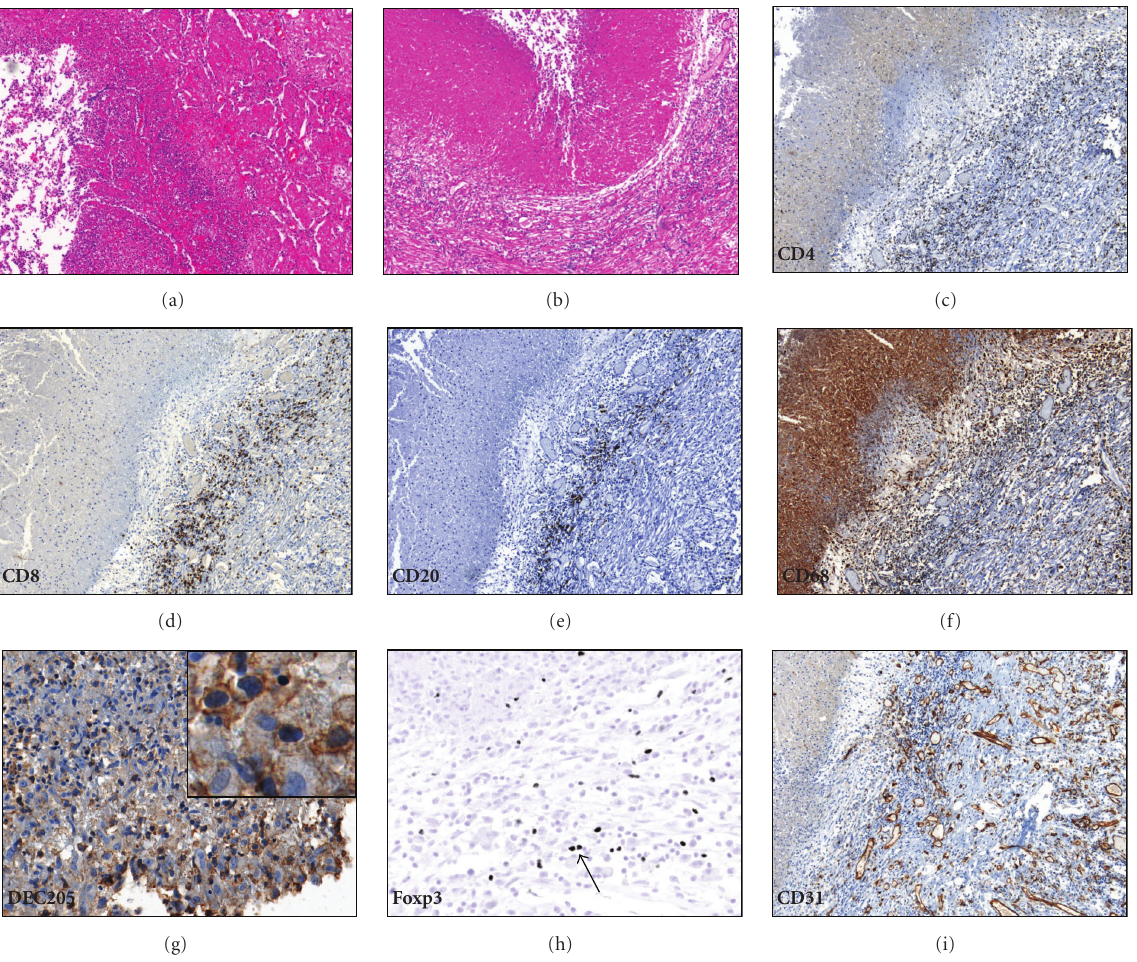
Figure 3: Immunopathology of cavitary lesions. (a) Early cavitary lesion, surrounded by lipid pneumonia, 100x. (b) Chronic cavitary lesion. The cavity wall consists of necrotic material, foamy macrophages, and fibrous tissue with abundant lymphocytes, 100x. (c) Numerous CD4+ cells make up the lymphocytic portion of a cavity wall, 100x. (d) CD8+ cells in the wall of a cavity, 100x. (e) CD20+ cells in the wall of a cavitary lesion, 100x. (f) The cells lining the cavity are CD68+ macrophages, 100x. (g) Foamy macrophages lining the cavity wall are positive for the dendritic cell marker DEC-205, 400x. Insert demonstrates a region detailing the staining for DEC-205. (h) Numerous Foxp3+ cells (arrow) were found in the cavity wall, 400x. (i) Abundant granulation tissue in the wall of a cavitary lesion noted with the CD31 stain,